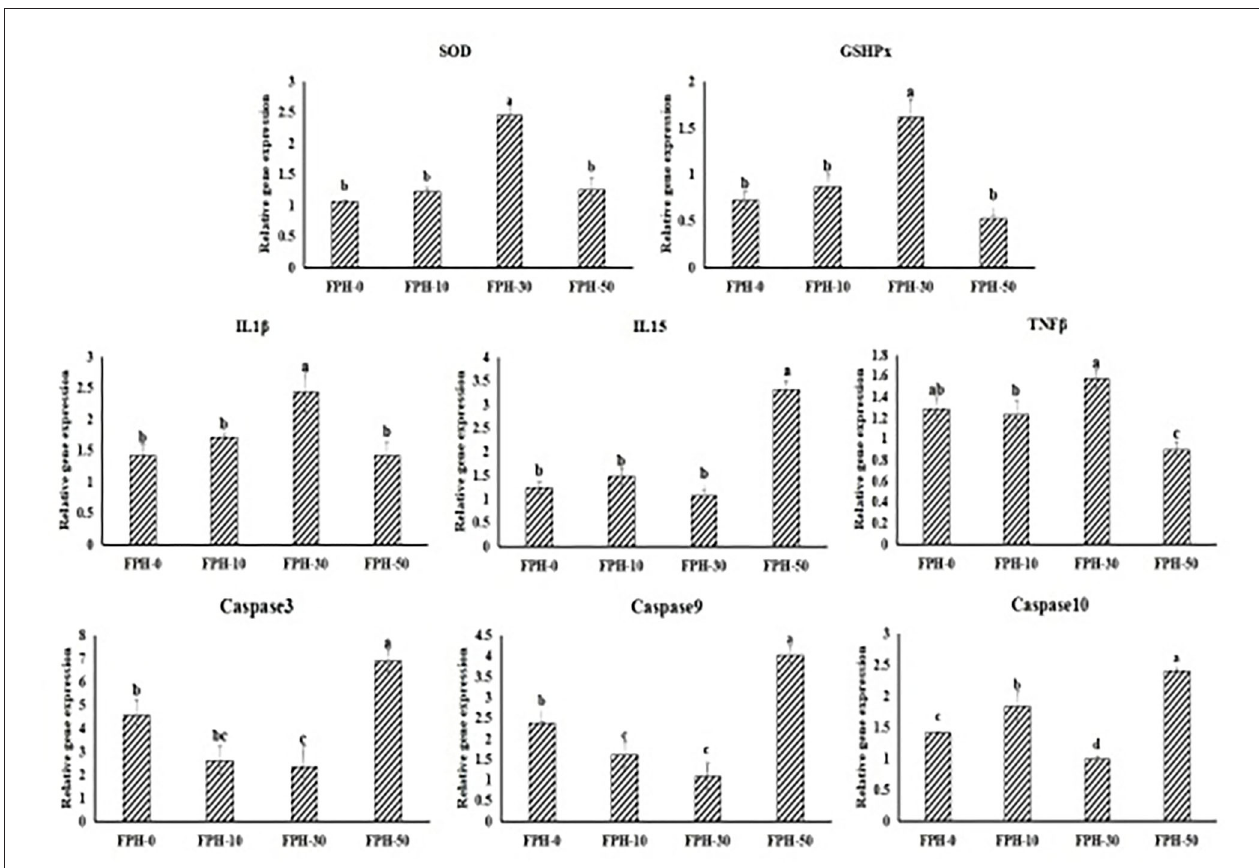
FIGURE 2 | Relative expression of immune response related gene in the intestine of largemouth bass ( Micropterus salmoides ) fed the diets containing different supplementation levels of fish protein hydrolysate